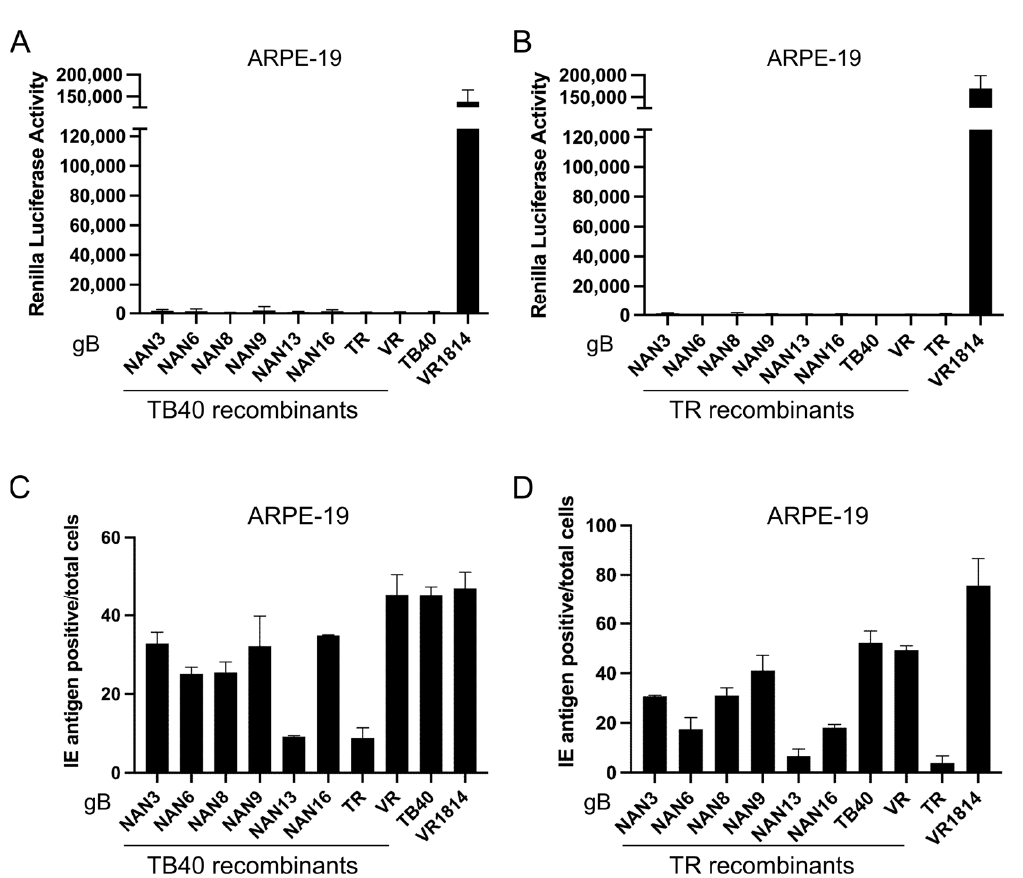
Figure 5. Cell–cell fusion and infectivity in ARPE-19 epithelial cells. ( A, B ) ARPE-19 cells expressing the DSP system were infected at an MOI of 1. Renilla luciferase activity was measured 3 days post-infection. ( C, D ) ARPE-19 cells were infected at an MOI of 1. The percentage of IE-antigen-positive cells was determined 3 days post-infection by immunofluorescence. The bar diagrams show means ± SD of three biological replicates.